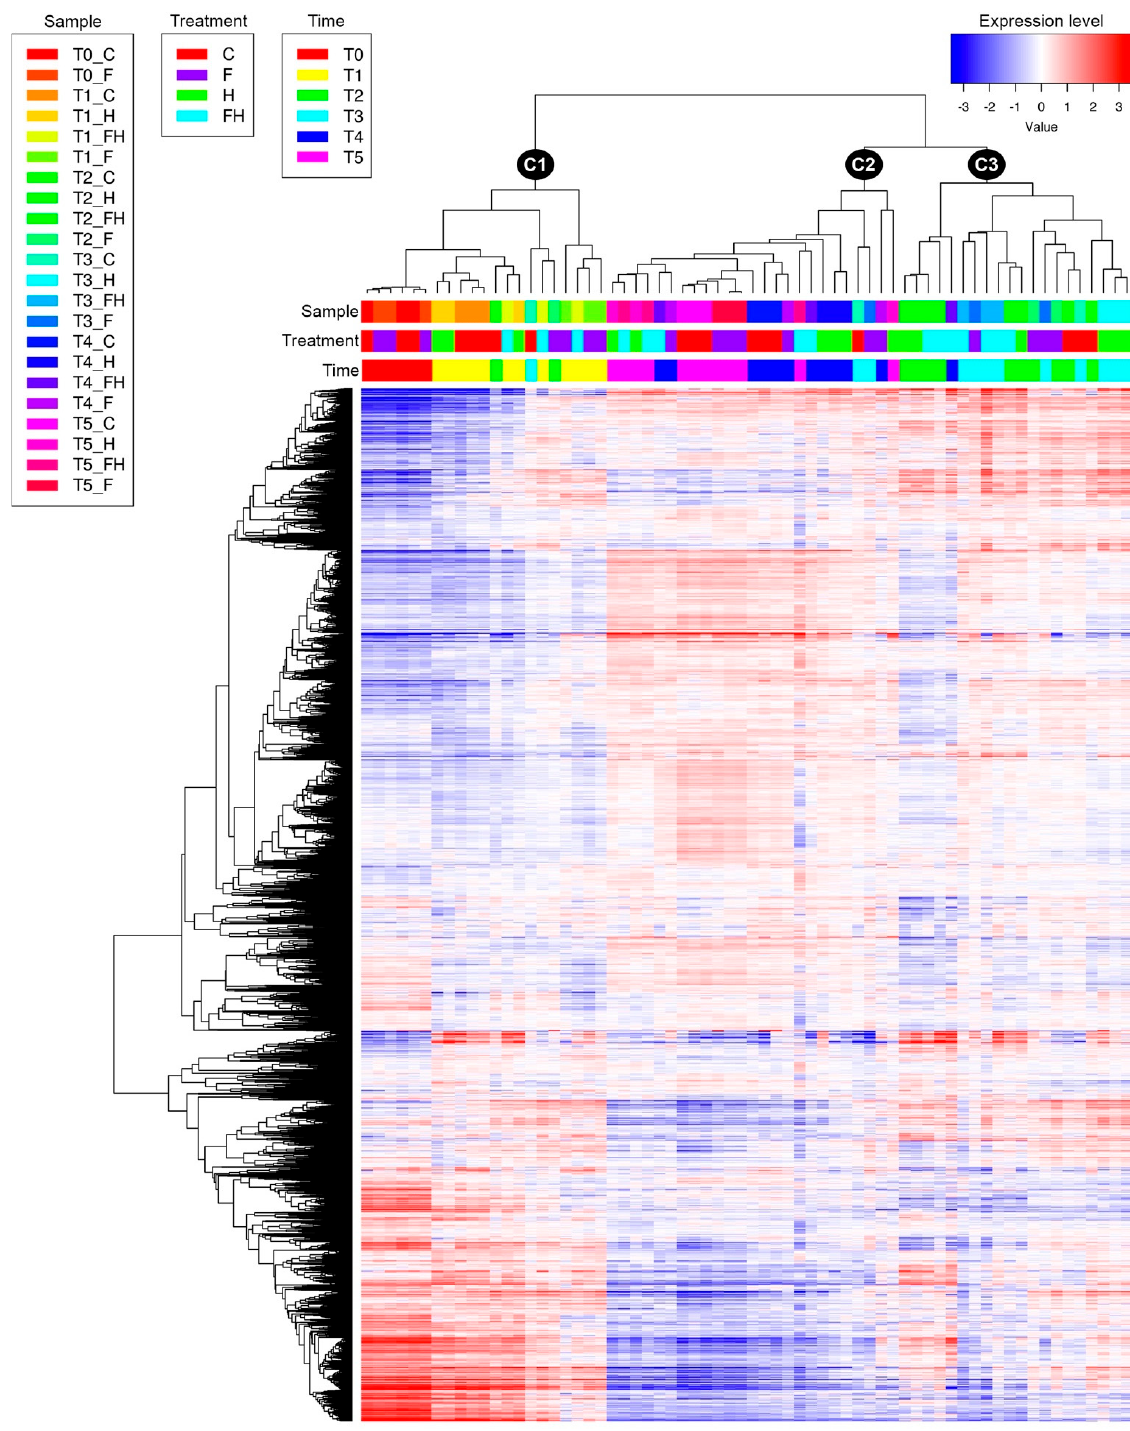
Figure 3. Heatmaps of the 5000 most variable genes and hierarchical clustering for both samples (columns) and genes (rows). The different replicates were marked at the top of the heatmap with different colors according to the sample to which they belong, the treatment (C, control; F, flooded; H, heatwave; FH, flooded plus heatwave), and the time of sample collection (a legend is provided on the top left). The three main clusters of samples (C1, C2, and C3) are indicated, and the scale of expression level is shown at the top